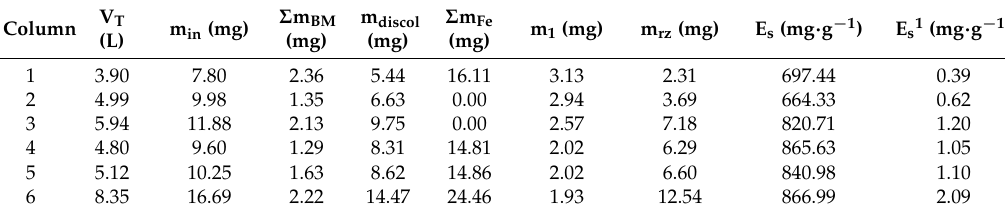
Table 3. Summary of the column experiments results. V T is the total volume of MB solution which flowed through individual columns. Σ m Fe and Σ m MB are, respectively, the effluent Fe and MB cumulative masses. m 1 and m rz are calculated after Equations (4) and (5). E s is the MB discoloration efficiency (Equation (2)) and E s1 the specific efficiency related to discoloration by H rz and H 1 . Results clearly show that PZ considerably enhances the sustainability of conventional Fe 0